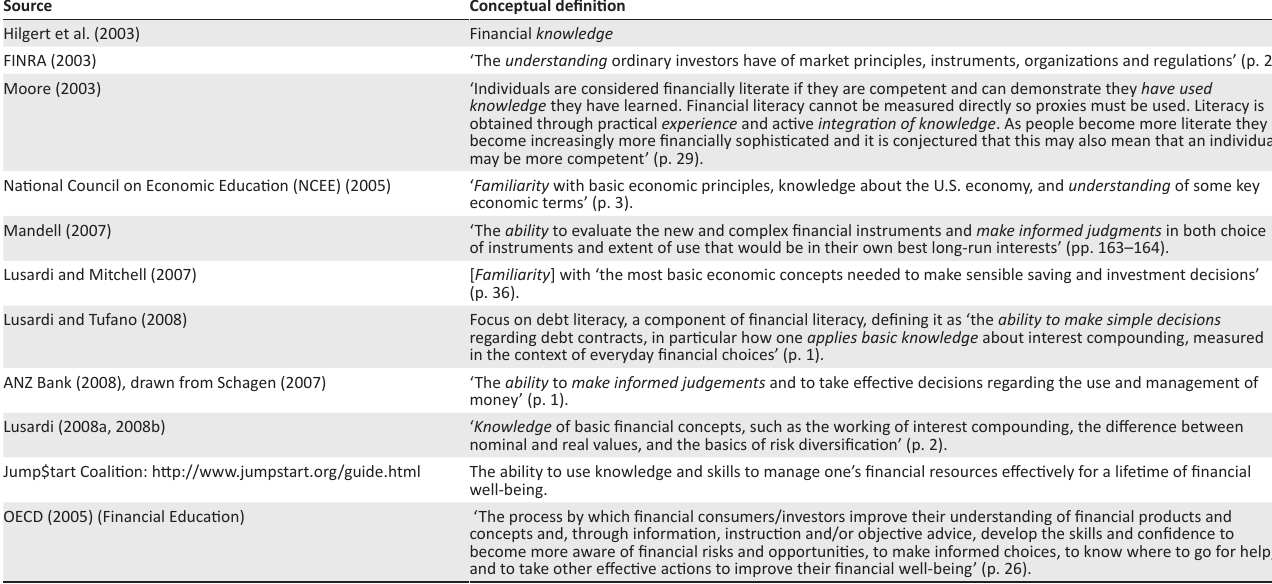
TABLE 1-A1: Conceptual definitions of financial